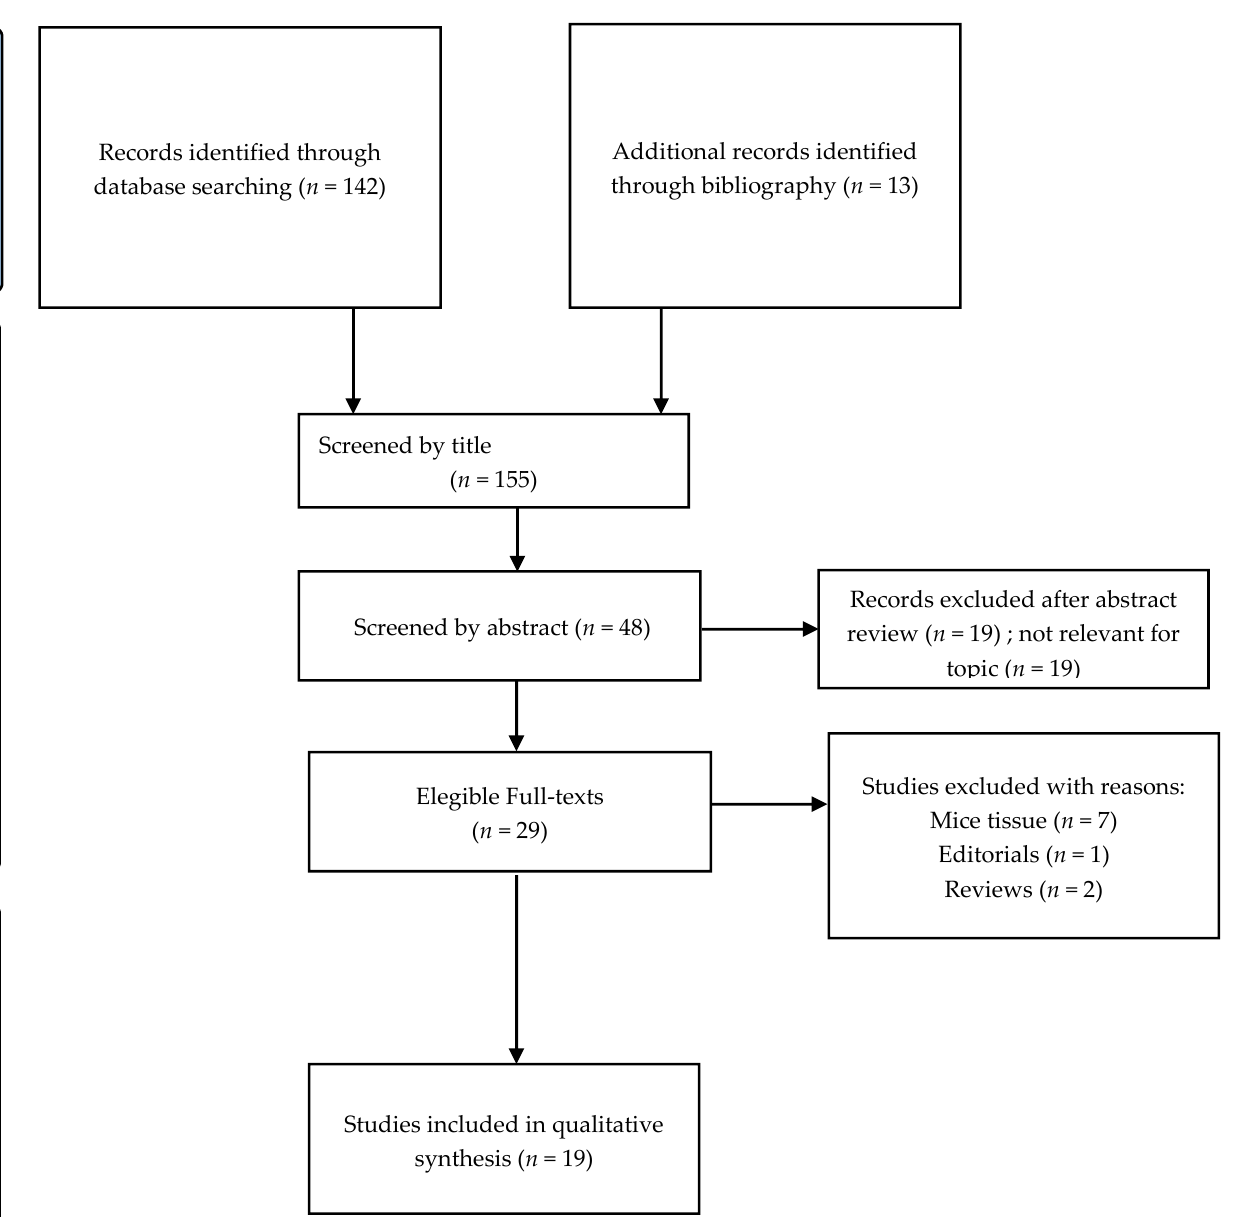
Figure 1. Literature search flowchart diagram for systematic review.